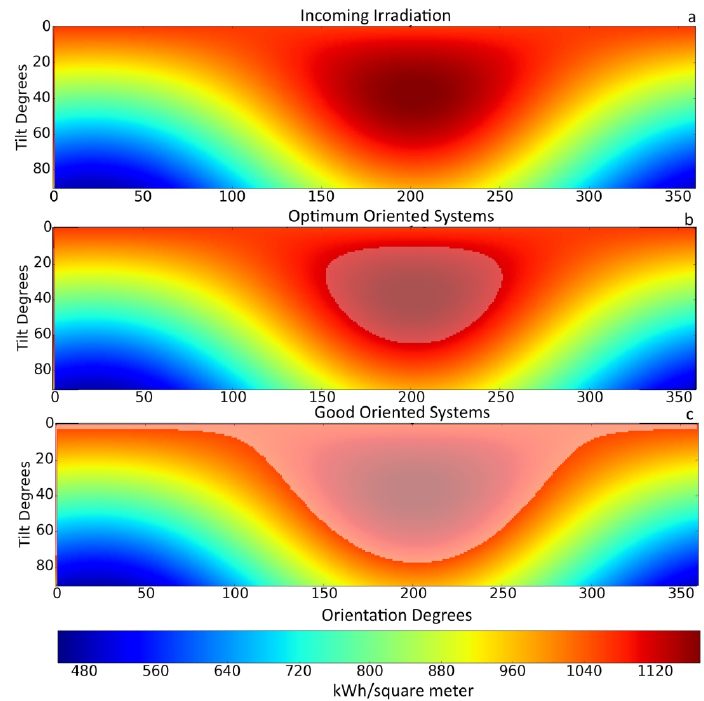
Figure 4. ( a ) Plane of Array (POA) irradiation; ( b ) optimum oriented systems; ( c ) well oriented